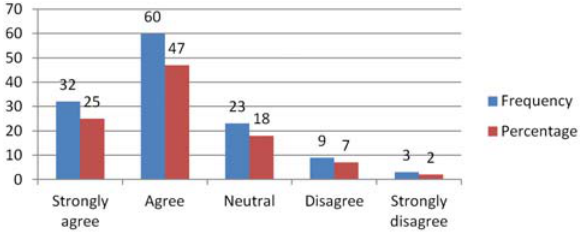
Fig. 3. Factors hindering rural SME investment